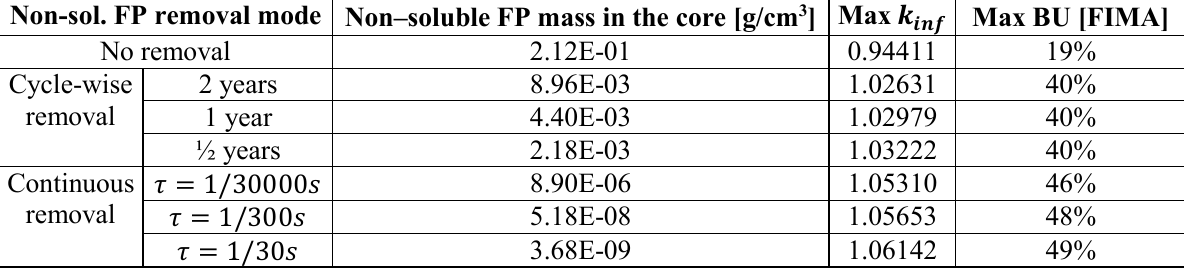
Figure 2. Comparison between non-soluble products removal strategies. Neutron multiplication factor as a function of average burnup. The fuel used is the previously introduced Uranium salt. Table II. Comparison of seven removal modalities: Comparison between neutronic performances of situations with different non-soluble products removal strategies (other than removal by